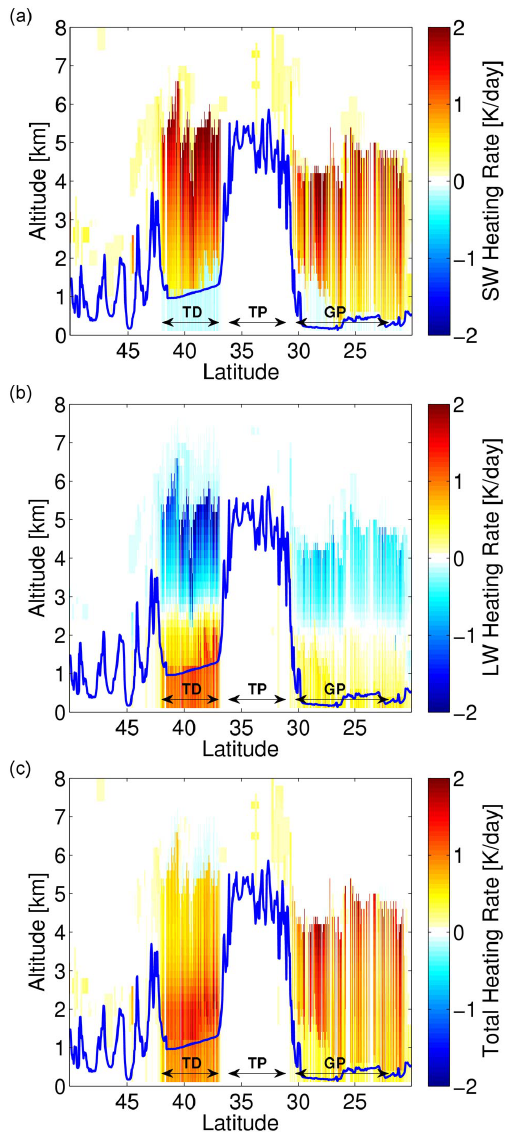
Fig. 6. Anomalies in (a) SW, (b) LW, and (c) Total (SW+LW) heat- ing rates induced by aerosols throughout the vertical extent of the atmosphere in K/day. MODIS surface albedo values and CALIPSO aerosol distributions are used as